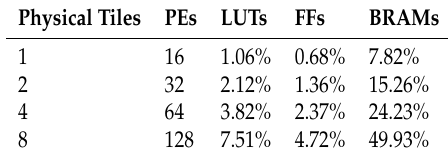
Table 2. FPGA resources utilization: percentage of the total number of LUTs, FFs and BRAMs. Within brackets we reported values before the place-and-route process (i.e., synthesis results only for the ringlets’ configurations).